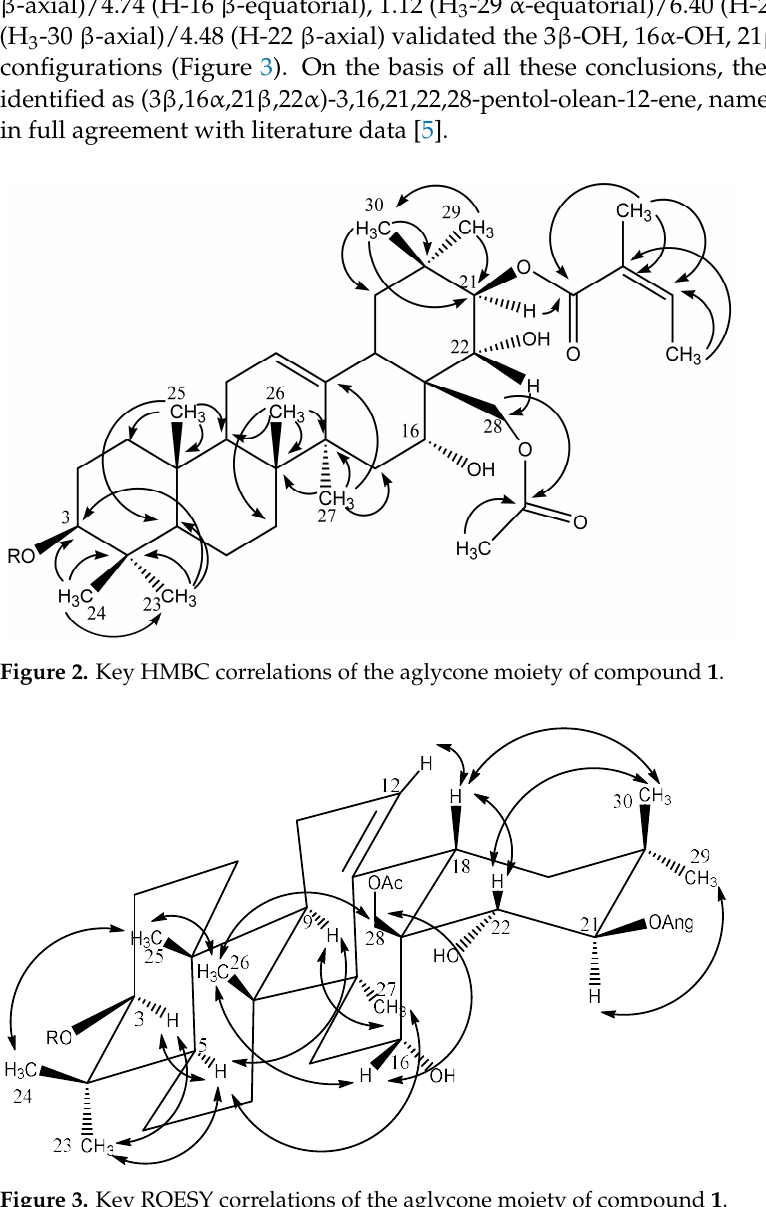
Figure 3. Key ROESY correlations of the aglycone moiety of compound 1 . The deshielded chemical shift of CH-21 at δ C / δ H 81.0/6.40 ppm and CH 2 -28 at δ C / δ H 66.2/4.26 ppm suggested an acylation at these positions. This was confirmed by the HMBC cross-peaks at δ H / δ C 6.40 (H-21)/168.8 (Ang-1) and δ H / δ C 4.26 (H 2 -28)/171.0 (Ac-1). At the C-21 position, the substituent was composed of two vinylic methyl groups at 2.01 (s) and 2.07 (d, J = 6.7 Hz) ppm, which correlated in the HMBC spectrum with one ethylenic quaternary carbon at 129.0 and an ethylenic methine carbon at 136.2 ppm. These data revealed an angeloyl group acylating the C-21 position (Table 1) [5]. The NMR signals for the acylating group at C-28 were in accordance with an acetyl function. Thus, the structure of the acylated aglycone was elucidated as 21- O -angeloyl-28- O -acetylbarringtogenol C. The presence of three sugar moieties in 1 was evidenced by the 1 H-NMR spectrum which displayed signals of three anomeric protons at δ H 4.85 (d, J = 7.3 Hz), 5.38